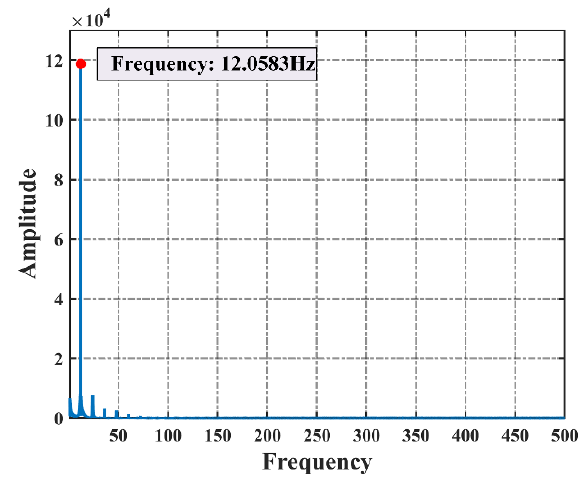
Figure 11. Trend of engine’s parameters change in surge test.